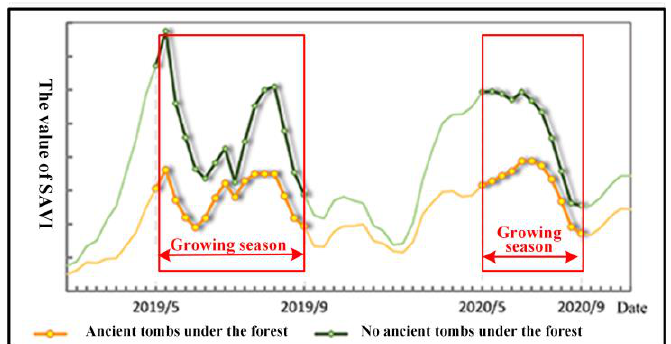
Figure 8. Timing-series features of SAVI.